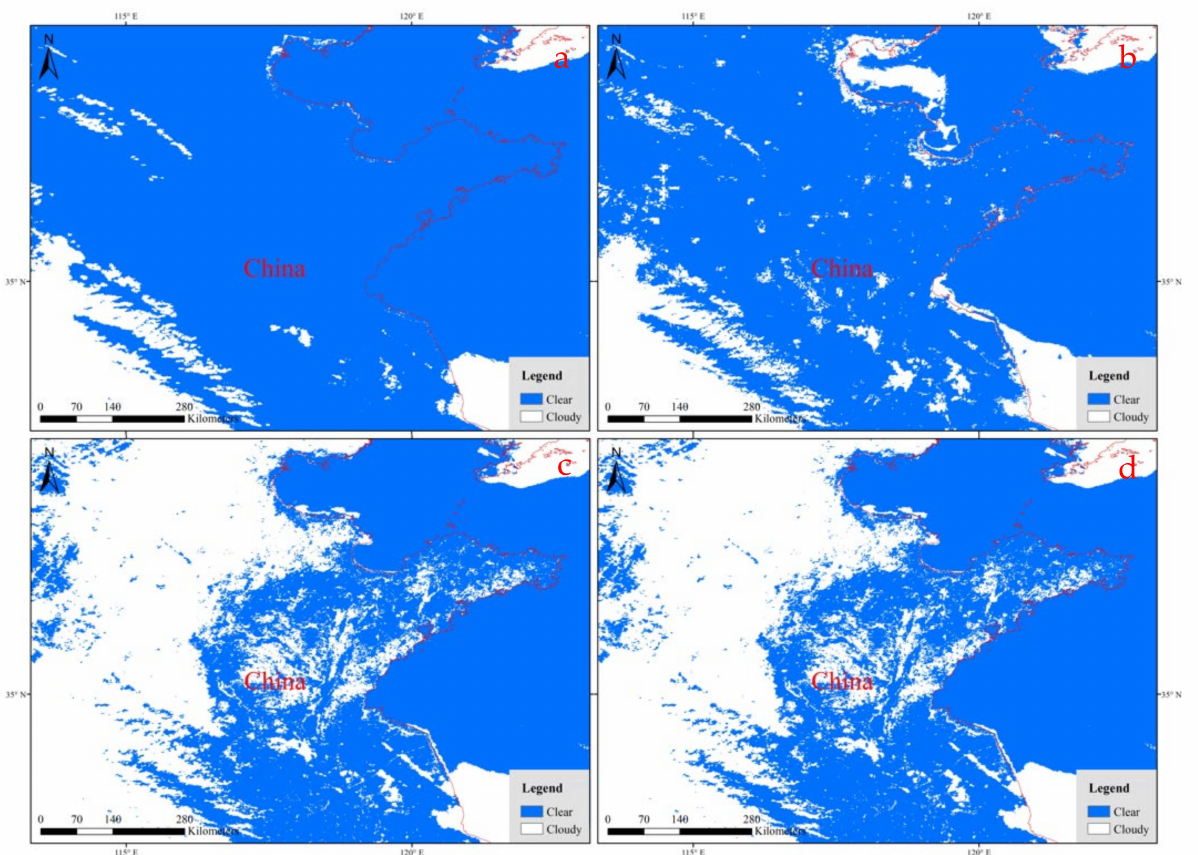
Figure 10. Cloud masks of Collection 5 ( a ) and 6 ( b ) of MOD09 and Collection 5 ( c ) and 6 ( d ) of MOD35 on 3 February